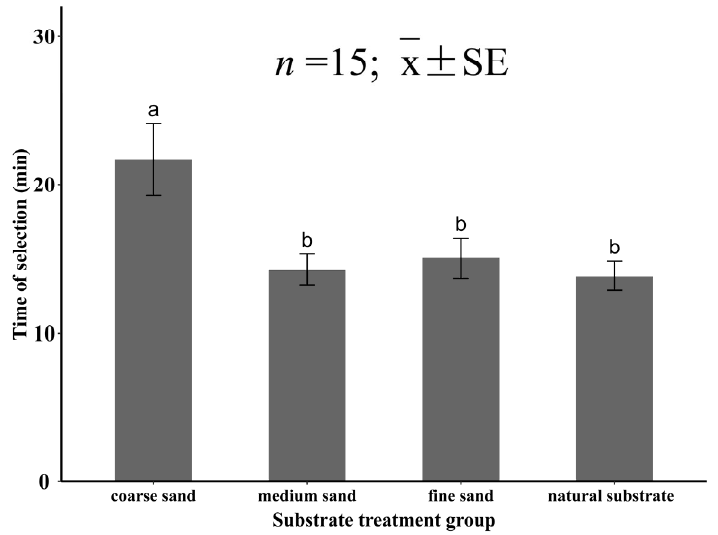
Figure 10. The selection time of juvenile Meretrix meretrix for different grain size substrates. The different letters above the bar graphs indicate significant differences ( p < 0.05).